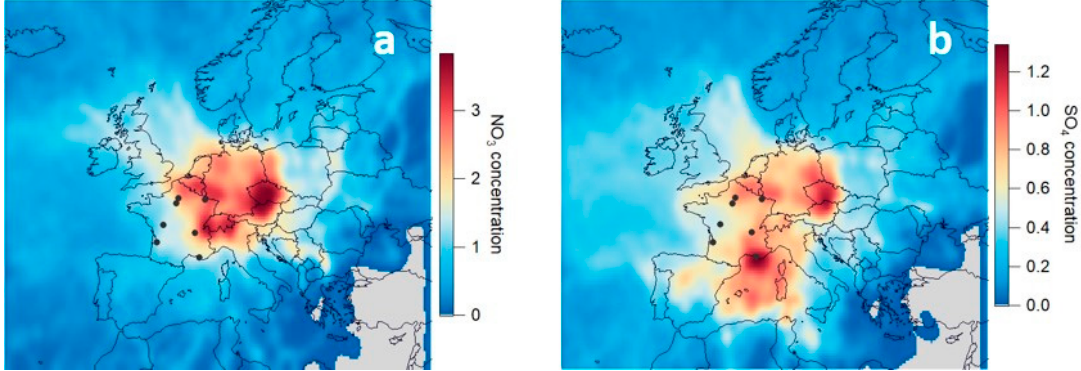
Figure 17. Multi-site concentration-weighted trajectory analysis of particulate nitrate ( a ) and sulfate ( b ) measured by ACSM in 2016–2017 at different CARA stations (SIRTA, Creil, Metz, Poitiers, Bordeaux, Lyon, and Marseille, black dots).